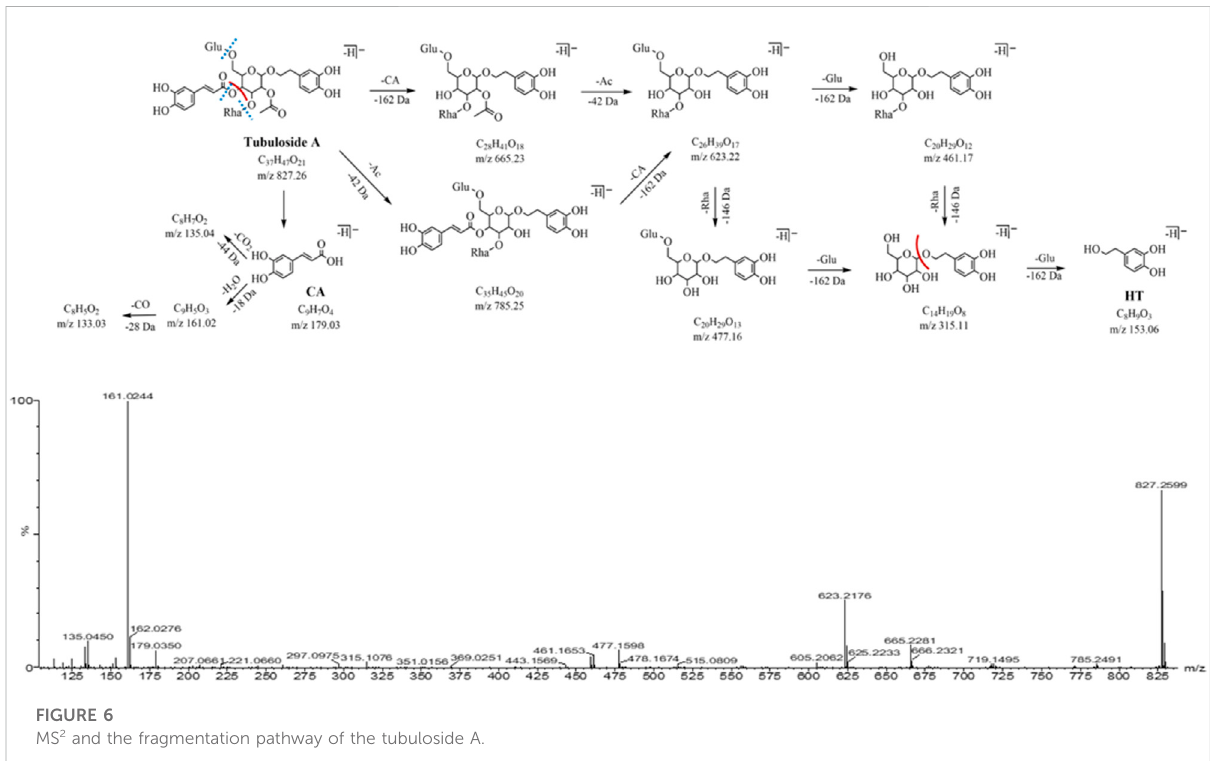
FIGURE 6 MS 2 and the fragmentation pathway of the tubuloside A.